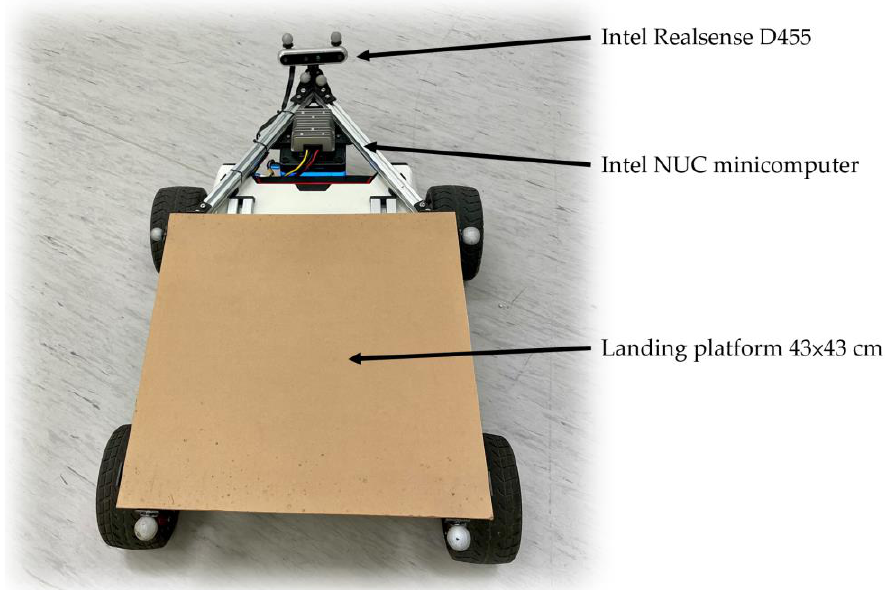
Figure 6. The hardware setup of the UGV landing platform .